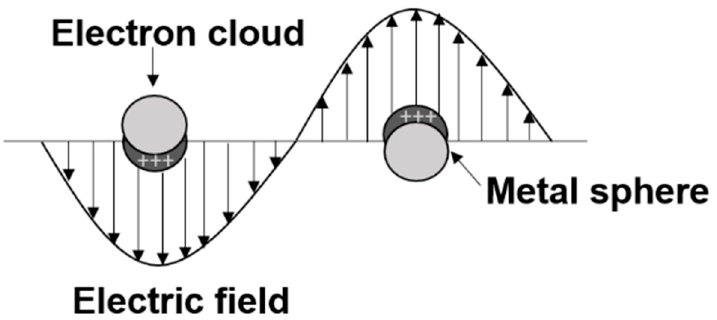
Figure 3. Schematic illustration of surface plasmons propagating at the interface between metal nanoparticle and dielectric materials [40].